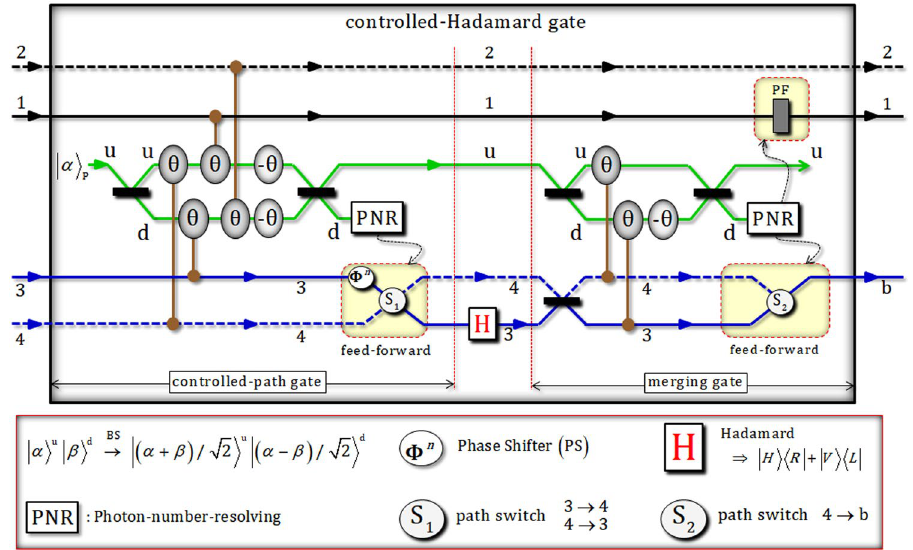
Figure 4. The controlled-Hadamard gate: This gate consists of controlled-path and merging-path gates using weak XKNLs, qubus beams, and PNR measurements. Paths of photons A and B are particularly arranged after a controlled-path gate. Hadamard operation is then performed on path 3 of photon B. Subsequently, the merging- path gate can merge to single path b of photon B. Finally, entire gates (controlled-path and merging-path) and an operation (Hadamard) can facilitate the controlled-Hadamard operation in terms of the state of two photons A and B. Also, probe beams (coherent state: α ) used in the controlled-path gate can be recycled to utilize probe beams of merging